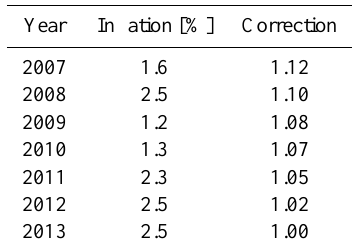
Table 1. Inflation adjustment according to the online database of Statistics Netherlands (2014). The average inflation per year for the Netherlands is used, based on the consumer price index. Every dam- age value associated with a year before 2013 was multiplied with a correction